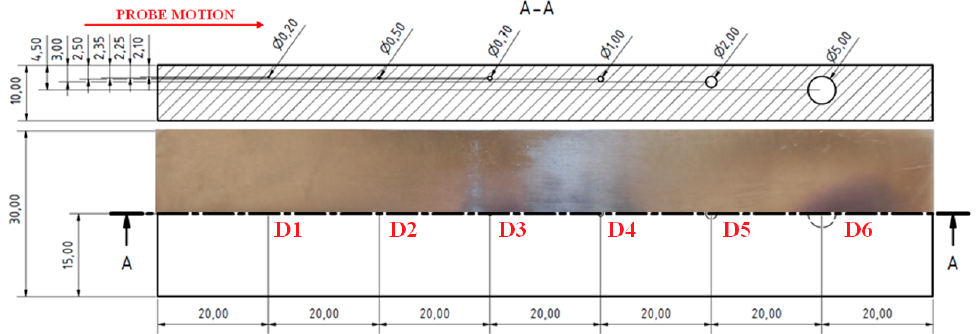
Figure 17. S5 Figure 17. S5 sample.